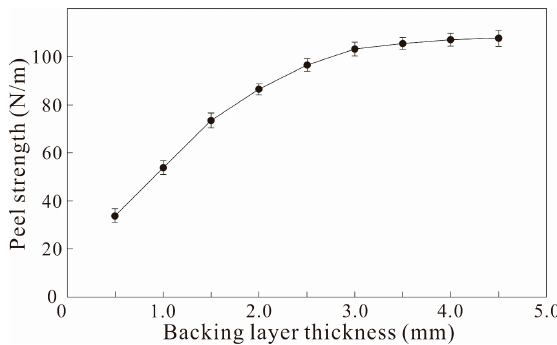
Figure 5. The influences of backing layer thickness on the peel strength at a peeling angle of 30° and at a peeling velocity of 2 mm/s.